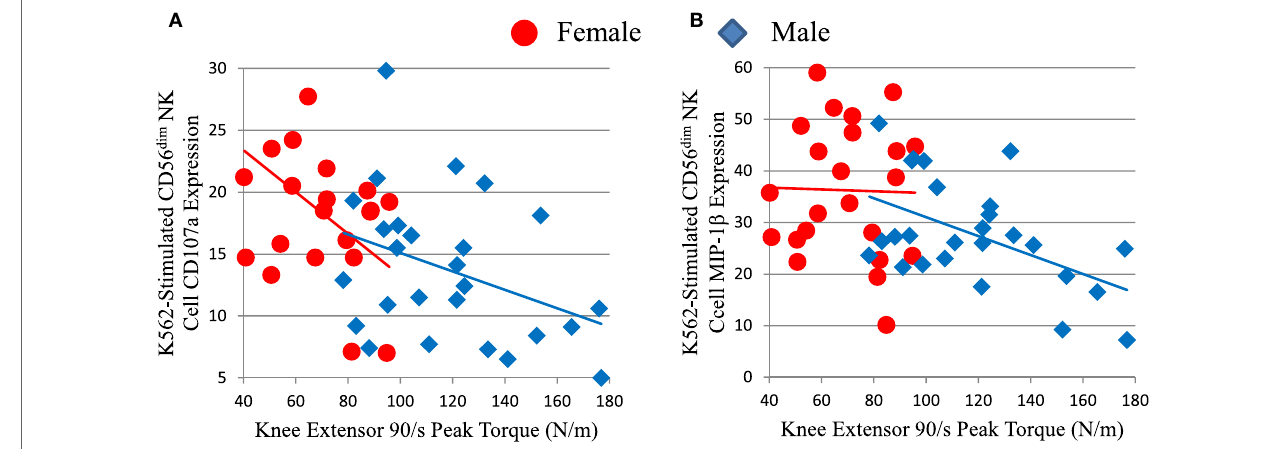
FigUre 6 | Strength (knee extensor peak torque) correlates inversely with measures of mature CD56 dim natural killer (NK) cell responses to K562 leukemia cells in cohort D. CD56 dim NK cell CD107a (a) is a measure of cytotoxic granule release and correlated inversely with peak torque for all subjects ( ρ = − 0.475, p = 0.001), but not for each sex considered individually. CD56 dim NK cell MIP-1 β chemokine production (B) correlated inversely with peak torque for all subjects ( ρ = − 0.384, p = 0.006), but not for each sex considered